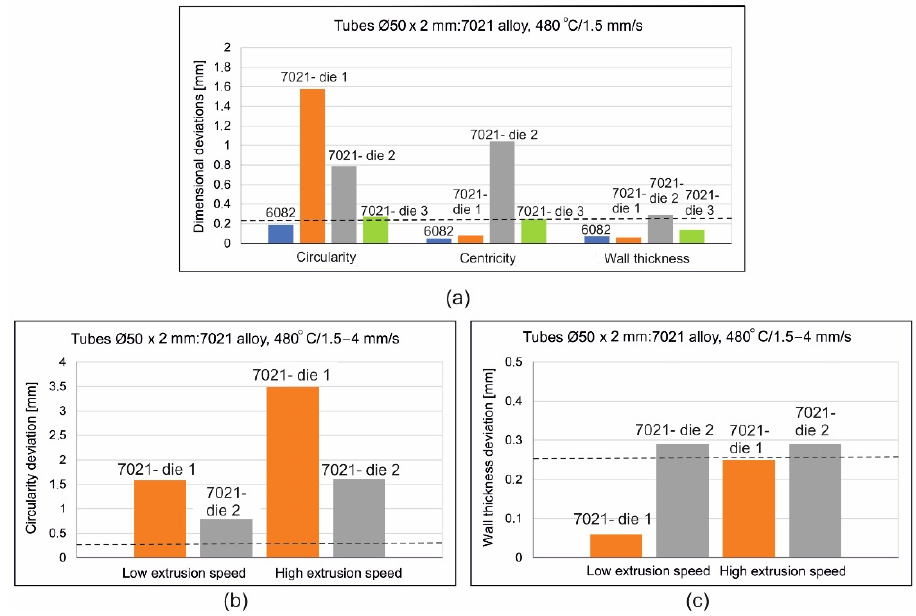
Figure 20. Results of optical scanning of the tubes of Ø50 × 2 mm extruded from 6082 alloy through 4-hole die and from 7021 alloy extruded through die 1, die 2 and die 3, ( a )—comparison of deviations for tubes extruded from 6082 and 7021 alloys, ( b )—circularity deviations for 7021 alloy, ( c )—wall thickness deviations for tubes from 7021.